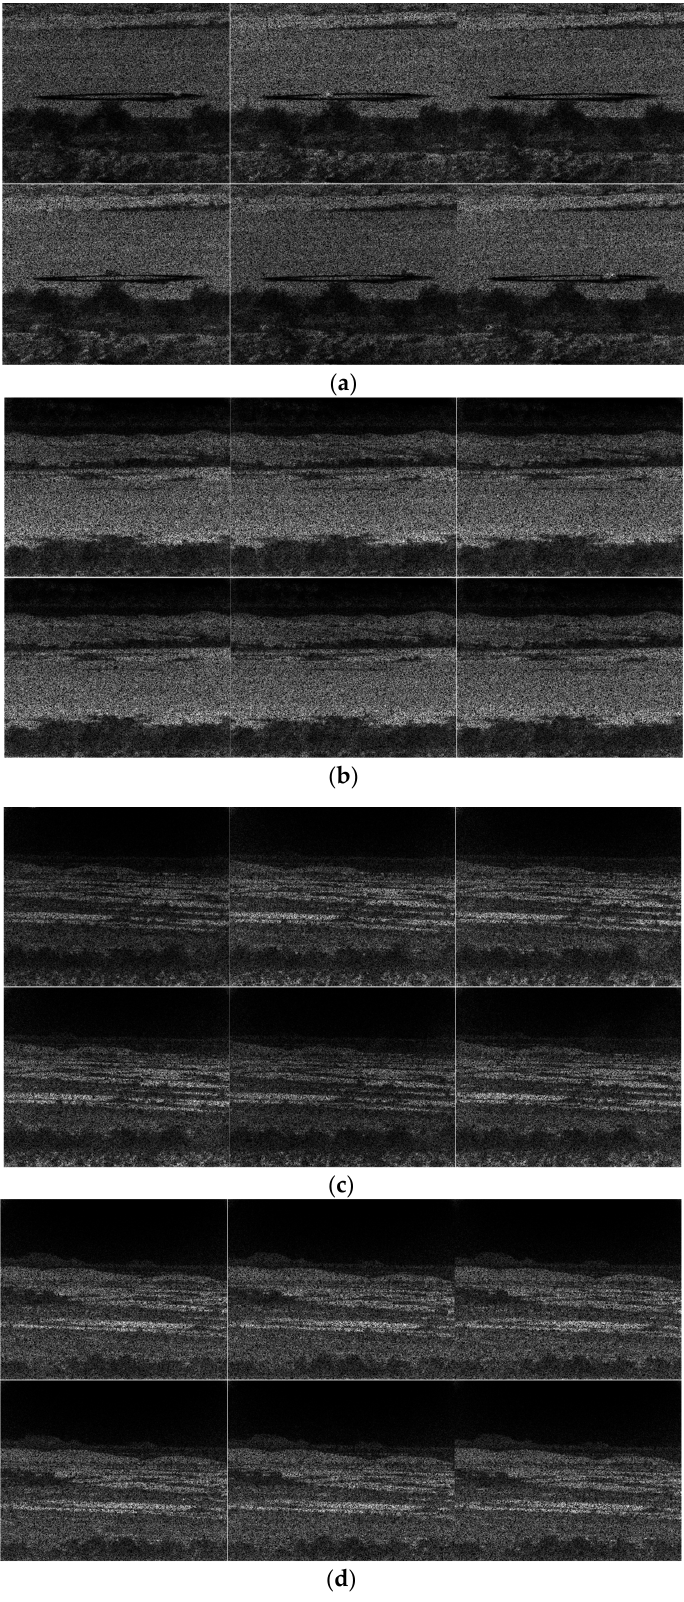
Figure A3. Tracking results for frames 1, 60, 119, 178, 237, and 296 for the PCE 50 (MWIR daytime) case. The vehicle is SUV. No detection is observed in the sampled frames. ( a ) 1000 m; ( b ) 2000 m; ( c ) 2500 m; and ( d ) 3500 m. Table A6. Tracking metrics for PCE 25 (MWIR daytime) case. 1500 m and 3000 m were used for training.